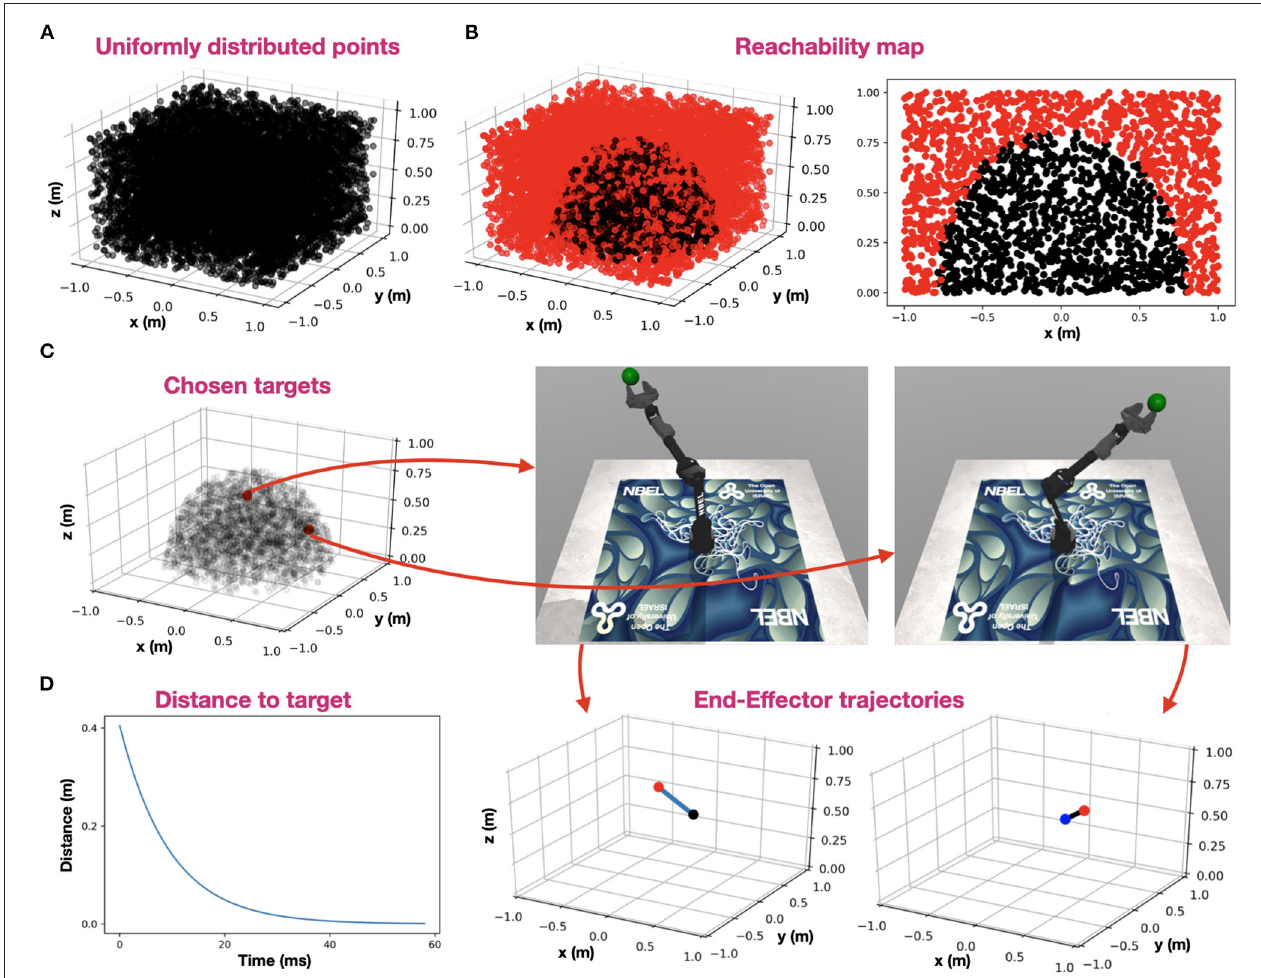
FIGURE 5 | Robot control. (A) uniformly distributed 10,000 target points in a 2 × 2 × 1 meters volume; (B) IK reachability map, where a black point designates a reachable point with an accuracy of at least 1mm and a red point designates a non-reachable point. Arm base is located at the origin (0, 0, 0). A 3D reachability map is shown in the left panel, and a cross-section at y = 0 is shown in the right panel; (C) Two random points (red) were chosen among the reachable points (semi-transparent black). The arm configuration, resolved for each of the two target points are shown on the right, and the corresponding EE trajectories are shown on the bottom (target is indicated with a red point, EE-origin with a black point and trajectory in blue); (D) Distance to the furthest target while reaching it using PID